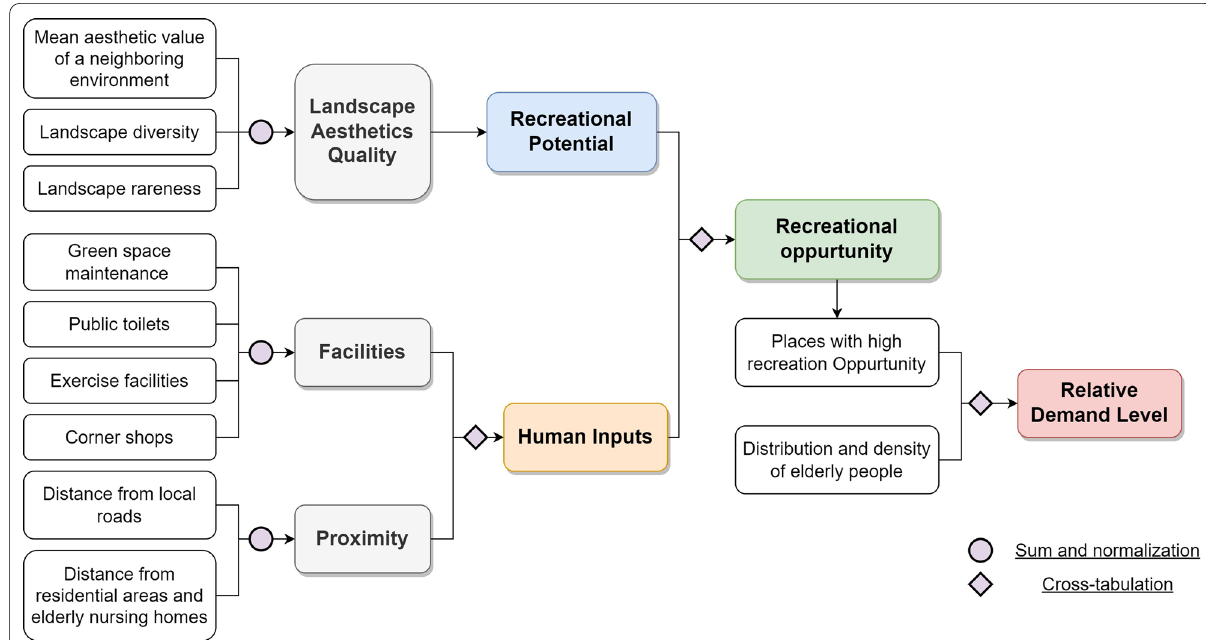
Fig. 5 Flowchart for assessing the recreational potential, opportunities, and relative demand for NBR among elderly people. Following the ESTIMAP model’s rule, this study applies either sum-and-normalization or cross-tabulation to analyse the relationship between different